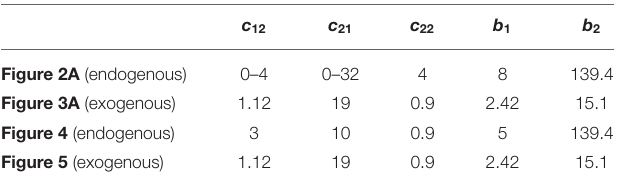
TABLE 1 | Parameters of the firing-rate model (1) used in numerical simulations to obtain Figures 2A , 3A , 4 , 5